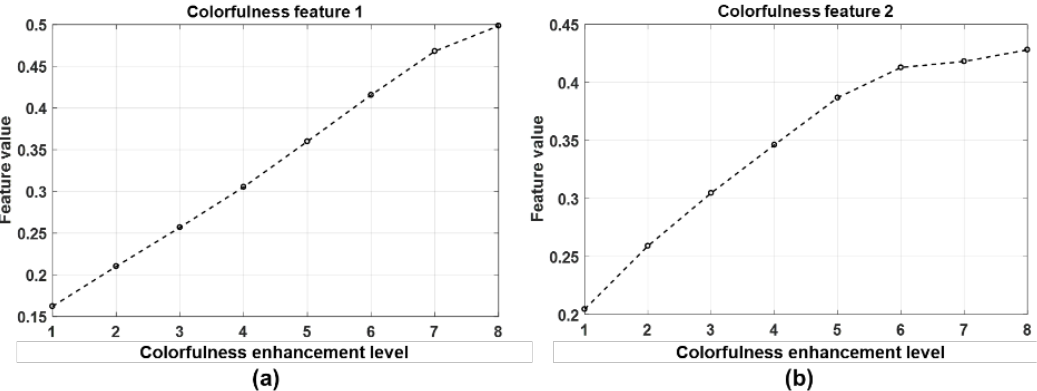
Figure 3. Comparison graph between the color adjustment level and calculated colorfulness features. Colorfulness feature 1 and 2 represent the global and local aspects of the colorfulness of the image, respectively.